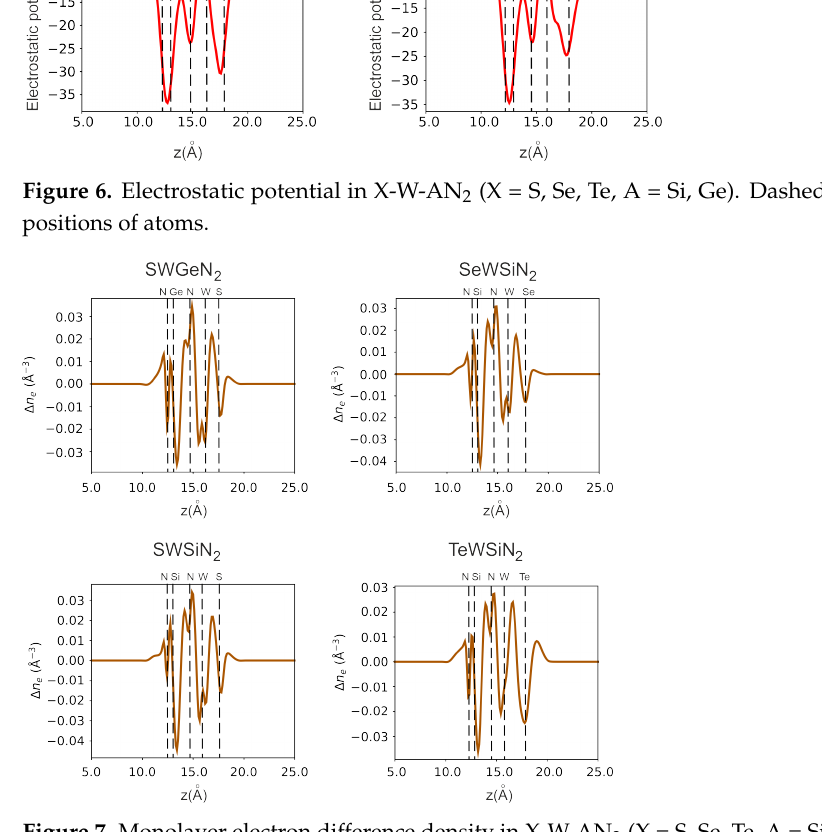
Figure 7. Monolayer electron difference density in X-W-AN 2 (X = S, Se, Te, A = Si, Ge). One way to change the bandgap is to stretch the monolayer in the plane. Figure 8 shows the stress (a) and bandgap (b) versus strain. In addition, elastic moduli, Young’s modulus Y , and Poisson’s ratio ν are listed in Table 3. Deviation from the linear Hooke’s law takes place at deformations greater than 0.1% for SWGeN 2 and SeWSiN 2 , for SWSiN 2 and TeWSiN 2 deviation from linearity is observed at deformations exceeding 3 % (Figure 8a). Due to the higher Young’s modulus, SeWSiN 2 stretches worse than other structures, and when it reaches 10% deformation, it fractures. For comparison, the values ??of elastic moduli for graphene and MoS 2 are also given. Young’s modulus XWSiN 2 is close to the value of graphene and is 2.5 times higher than that of two-dimensional molybdenite. Poisson’s ratio of SWGeN 2 is close to values of